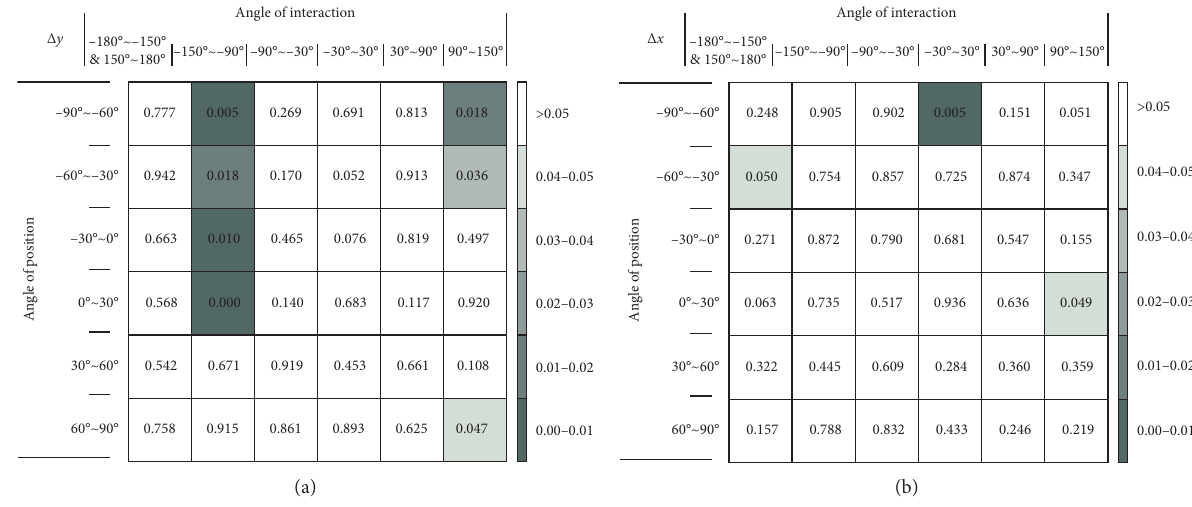
Figure 9: The p value of the number of interacting pedestrians with lateral and longitudinal